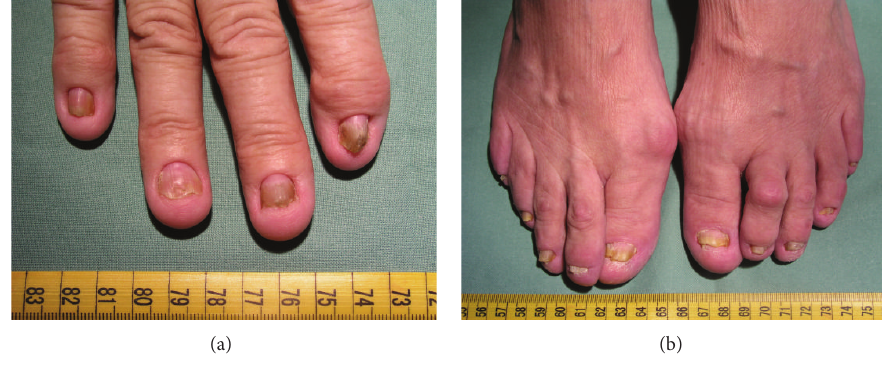
Figure 1: Atrophic changes of fingernails, hands, and feet.